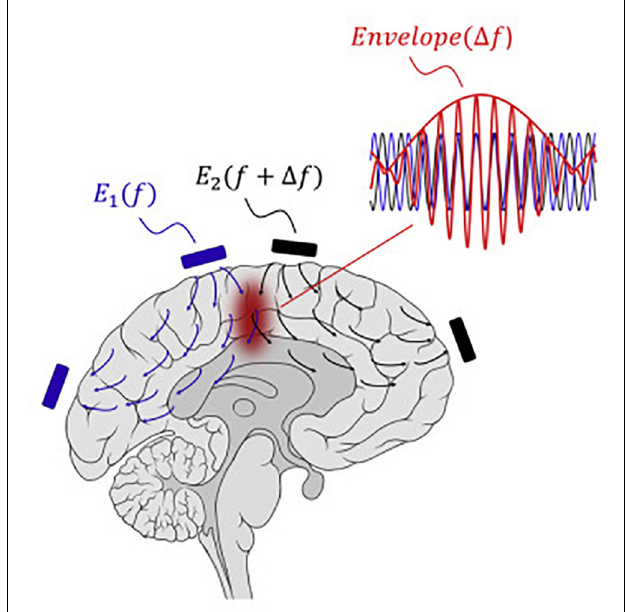
FIGURE 5 | Temporal interference as a non-invasive DBS